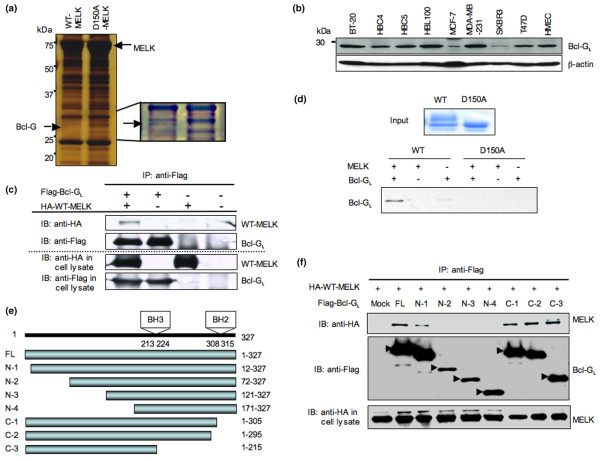
Identification of Bcl-GL as an interacting protein for MELK. (a) Silver staining of SDS-PAGE gels that contained the pulled-down cell lysates. The enlarged area covering Bcl-G shows the differential interaction between it and wild-type MELK (WT-MELK) and kinase-dead MELK (D150A-MELK). (b) Expression of Bcl-GL in eight breast cancer cell lines as well as human mammary epithelial cells (HMECs) by western blot analysis with an anti-Bcl-GL antibody. β-Actin was used as a control. (c) Interaction of MELK with Bcl-GL. Extracts from HeLa-cells transfected with HA (hemagglutinin)-tagged WT-MELK (HA-WT-MELK) or Flag-tagged Bcl-GL (Flag-Bcl-GL), or a combination of these, were harvested 36 hours after transfection. The cell lysates were immunoprecipitated with anti-Flag M2 antibody. Precipitated proteins were separated by SDS-PAGE and western blotting analysis was performed with an anti-HA antibody. (d) Direct interaction of the MELK and Bcl-GL proteins. The upper panel indicates the amount of input of WT-MELK and D150A-MELK. His-tagged WT-MELK bound to Bcl-GL, but His-tagged D150A-MELK did not. (e) Schematic representation of the amino- and carboxy-terminal deletion constructs of Bcl-GL. The C-1 and C-2 constructs have the BH2 domain deleted, and the C-3 construct has both the BH2 and BH3 domains deleted. (f) Determination of the WT-MELK binding regions of Bcl-GL by immunoprecipitation. The HA-tagged WT-MELK and various peptide sequences of Flag-tagged Bcl-GL (Figure 3e) were pulled down by immunoprecipitation with Flag-M2 antibody and then immunoblotted with rabbit anti-Flag antibody. The expression of HA-tagged WT-MELK in total cell lysates was confirmed by western blotting analysis. As a control, immunoprecipitation was performed from cells co-transfected with pCAGGSn3FC (Mock) and HA-tagged WT-MELK (HA-WT-MELK) through all steps. Arrowheads indicate expression of each Bcl-GL peptide.